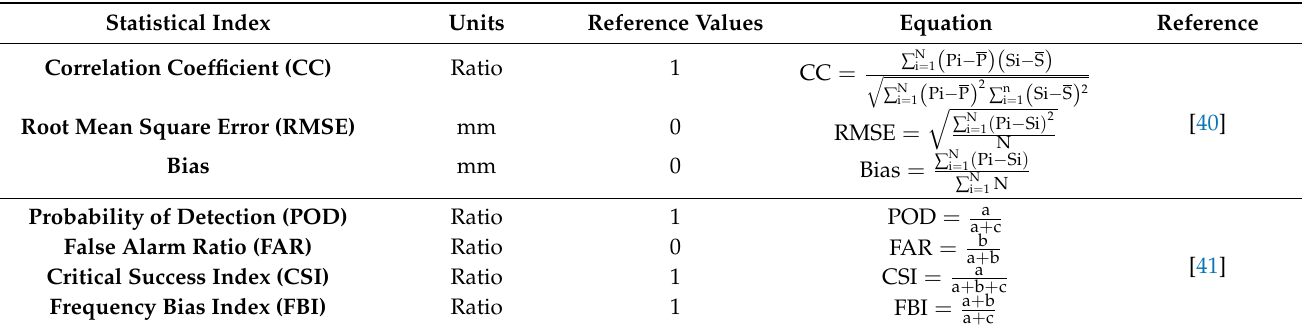
Table 1. Statistical metrics for evaluating IMERG V5 and 3B42 V7